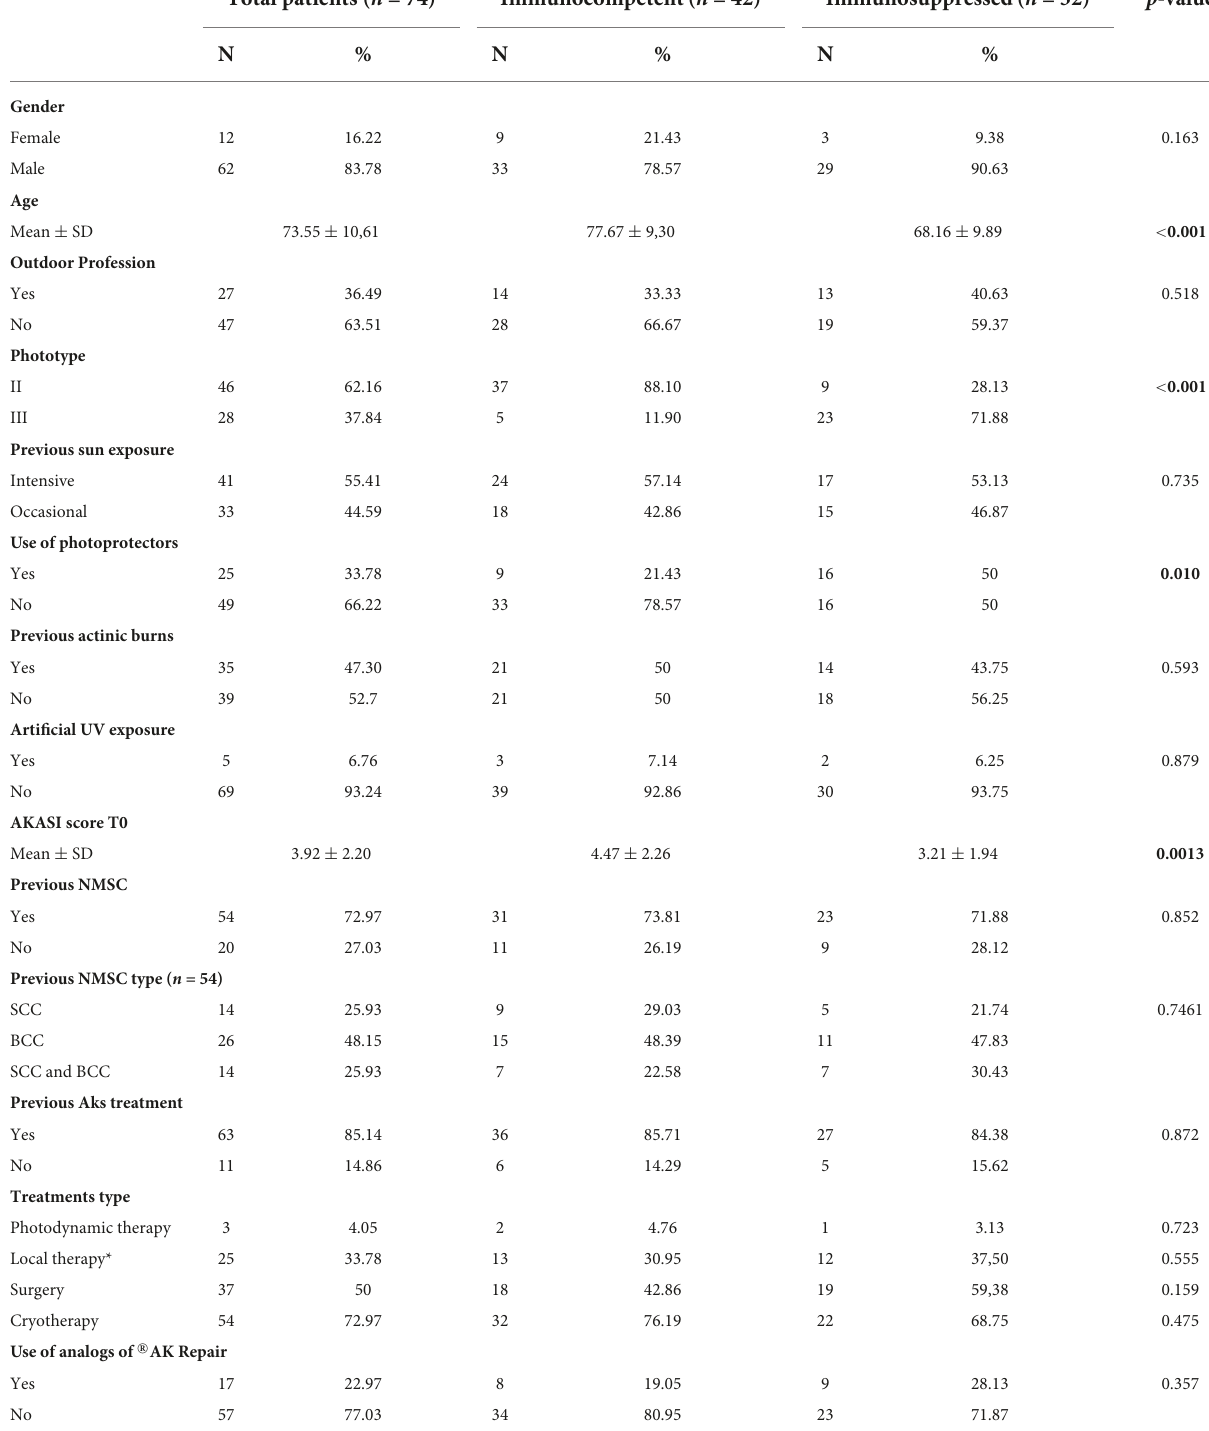
TABLE 3 A descriptive comparison of risk factors and anamnestic data between the two groups of patients. Total patients ( n = 74) Immunocompetent ( n = 42) Immunosuppressed ( n = 32) p